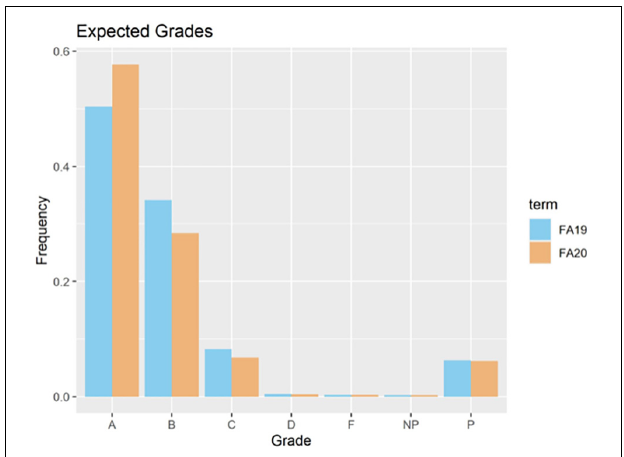
FIGURE 1 | Distribution of grades expected by students prior to finals week in CAPE surveys in Fall 2019 and Fall